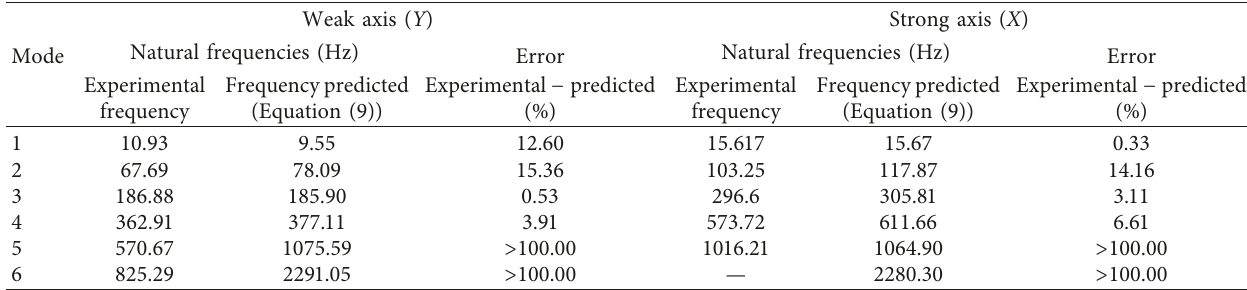
Figure 12: Evolution of the first component of the mode shapes for different values of Δ K configuration ( Y Table 6: Experimental and predicted natural frequencies for the fixed-free configuration.